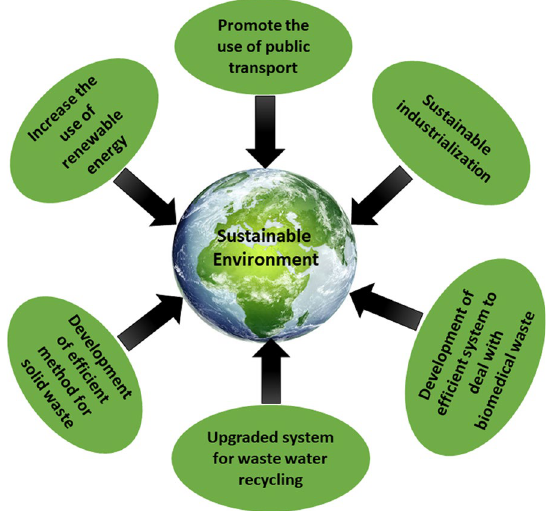
Fig. 2 A model for sustainable development of the environment in the post-covid